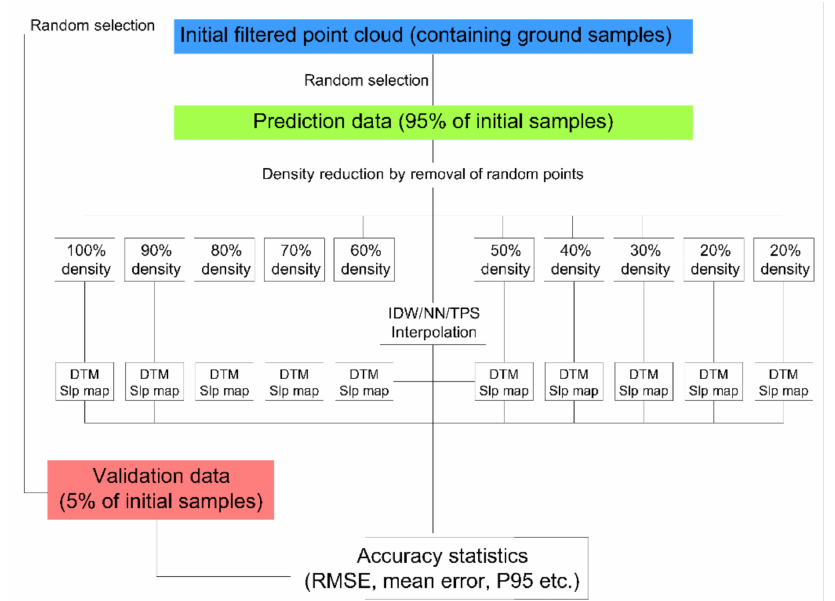
Figure 4. General research